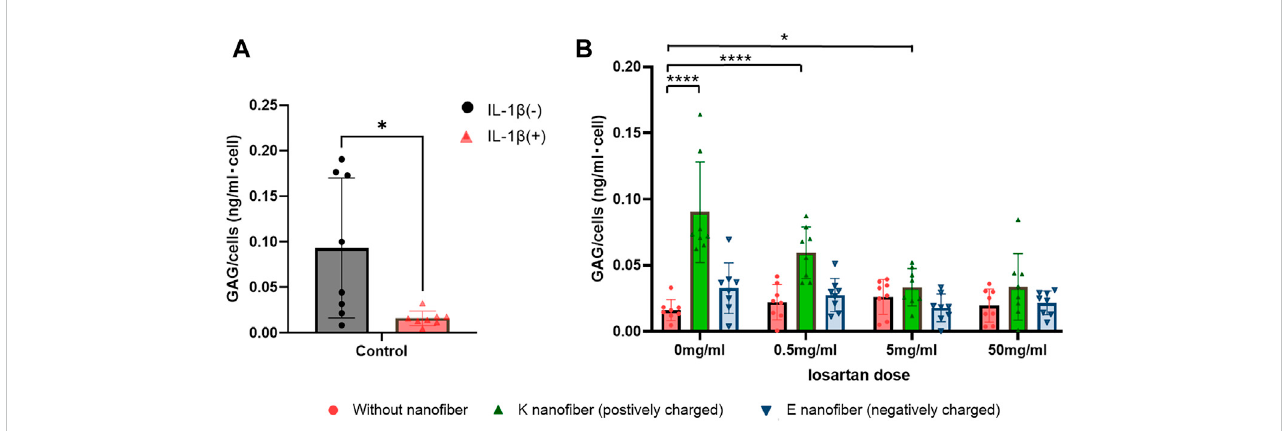
FIGURE 6 Positively charged nano fi bers with low doses of losartan promote GAG production. (A) GAG production is signicantly decreased in OA-induced chondrocytes 24 h after treatment with IL-1 β . C (black); without IL-1 β and ▲ (red); with IL-1 β . *; p < 0.05. N = 8 per each group. (B) Comparison of GAG productionpercellateachlosartandoseintheOA-inducedchondrocytes. C (red);withoutnano fi ber, ▲ (green);Knano fi ber(positivelycharged),and ▼ (blue); E nano fi bers (negatively charged). *; p < 0.05 and ****; p < 0.001. N = 8 per each group.